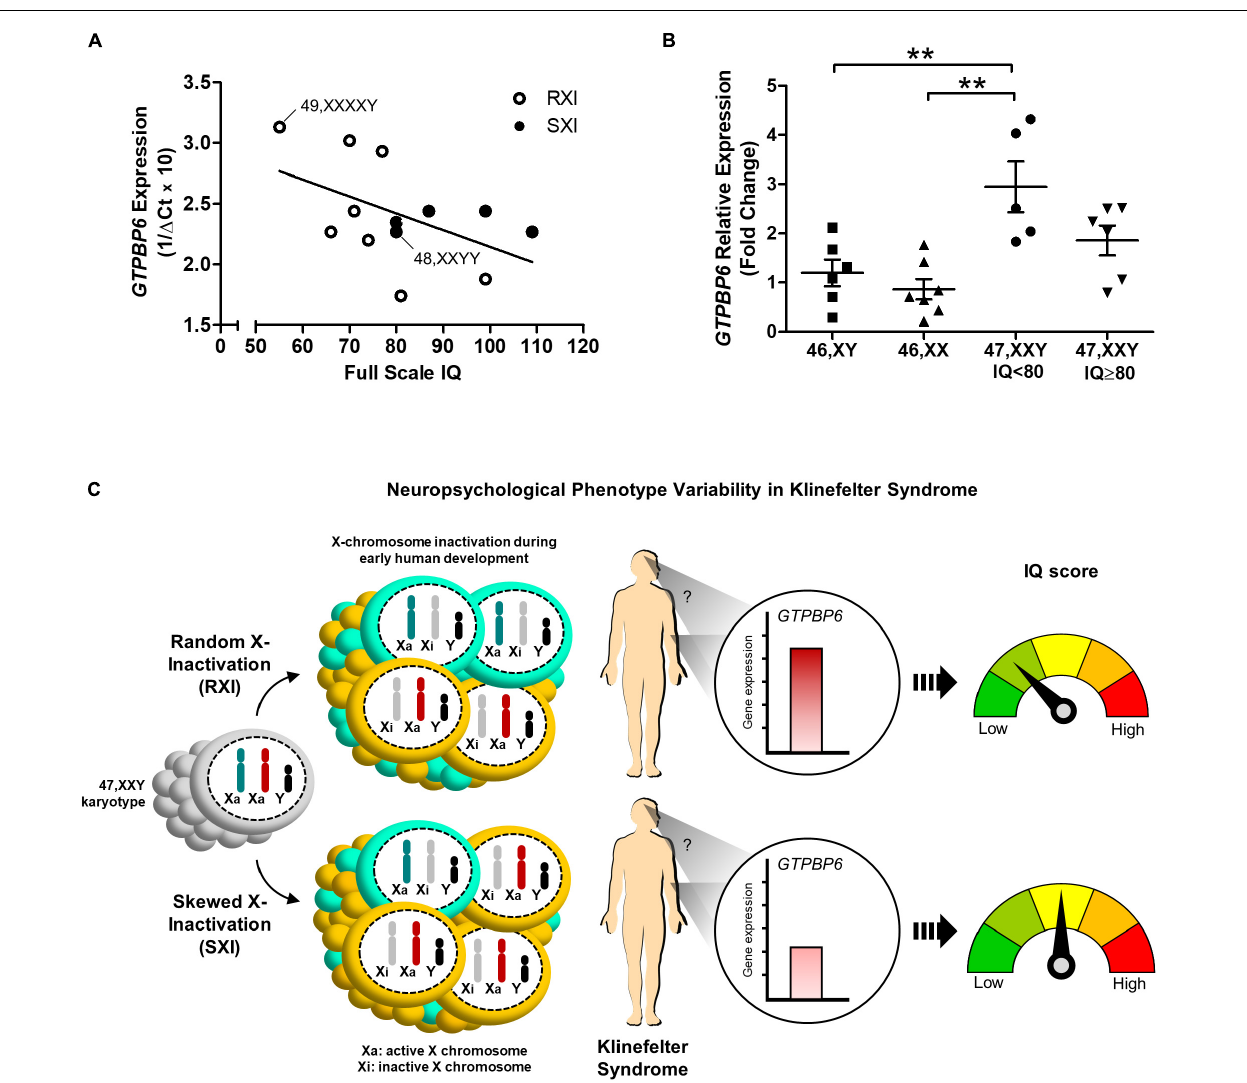
FIGURE 3 | Intelligence quotient variability in association with the X-chromosome inactivation pattern and GTPBP6 gene expression evidenced in Klinefelter syndrome patients. (A) Pearson’s correlation between GTPBP6 expression and full-scale intelligence quotient in Klinefelter patients. GTPBP6 expression was calculated as 1/ (cid:49) Cq using RPS8 as the reference gene. Higher 1/ (cid:49) Cq values indicate greater GTPBP6 expression. Linear regression was calculated (slope = –0.01385). Klinefelter and polysomic patients with RXI and SXI are represented with white and black circles, respectively. Correlation r = –0.5045, p = 0.0787. Polysomic subjects are indicated. (B) Peripheral blood GTPBP6 gene expression analysis in KS patients with IQ below the standard average of 80 ( n = 5) in comparison to both male (XY) and female (XX) controls. All KS patients with IQ < 80 presented a random X-inactivation pattern (RXI). Relative expression (fold change) is represented in relation to males. Note that GTPBP6 expression was higher in KS patients with IQ < 80 in comparison to both male and female controls ( p = 0.0012). Data are presented as mean ± SEM and statistical analysis used One-way ANOVA followed by Bonferroni test (** p < 0.01). (C) Hypothetical model for understanding of the correlation between intelligence quotient, X-inactivation pattern and altered GTPBP6 expression in Klinefelter patients. This model suggests that the intelligence quotient in KS individuals may reflect the X-inactivation pattern. Also, when presenting RXI, the GTPBP6 expression may be elevated and the intelligence quotient is low. On the other hand, when presenting the SXI pattern, the GTPBP6 expression is low and the intelligence quotient is average. Our data indicate that the SXI pattern may downregulate GTPBP6 expression, leading to a better cognitive performance in KS patients. Color schemes for the XCI patterns show 50% of the cells with the same Xi representing RXI, and 75% of the cells with the same Xi representing SXI, following the classification in Bolduc et al. (2008). IQ, intelligence quotient; RXI, random X-inactivation; SXI, skewed